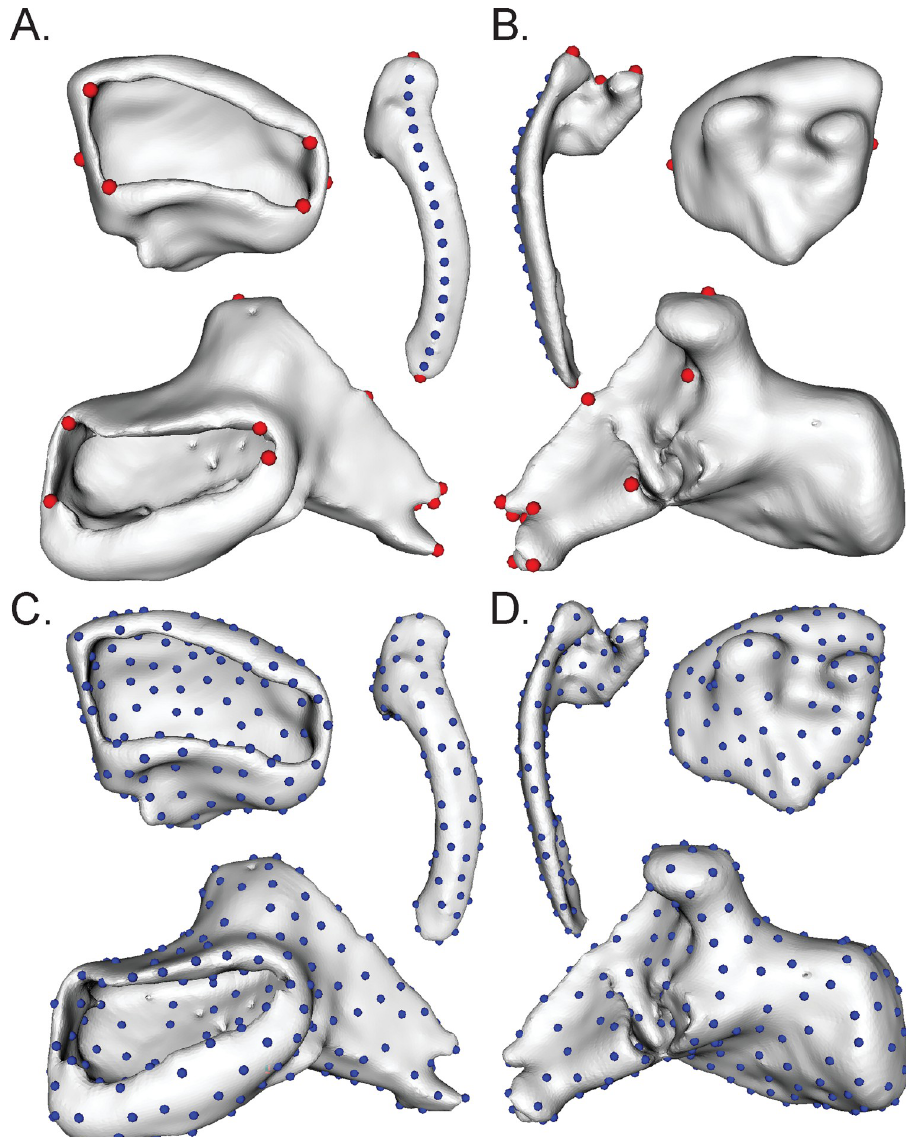
Fig 2. Traditional landmarks in the (A) ventral and (B) dorsal view (red dots homologous, landmarks, blue dots sliding landmarks), and automated landmarks in the (C) ventral and (D) dorsal view as shown on Gymnotocinclus anosteos